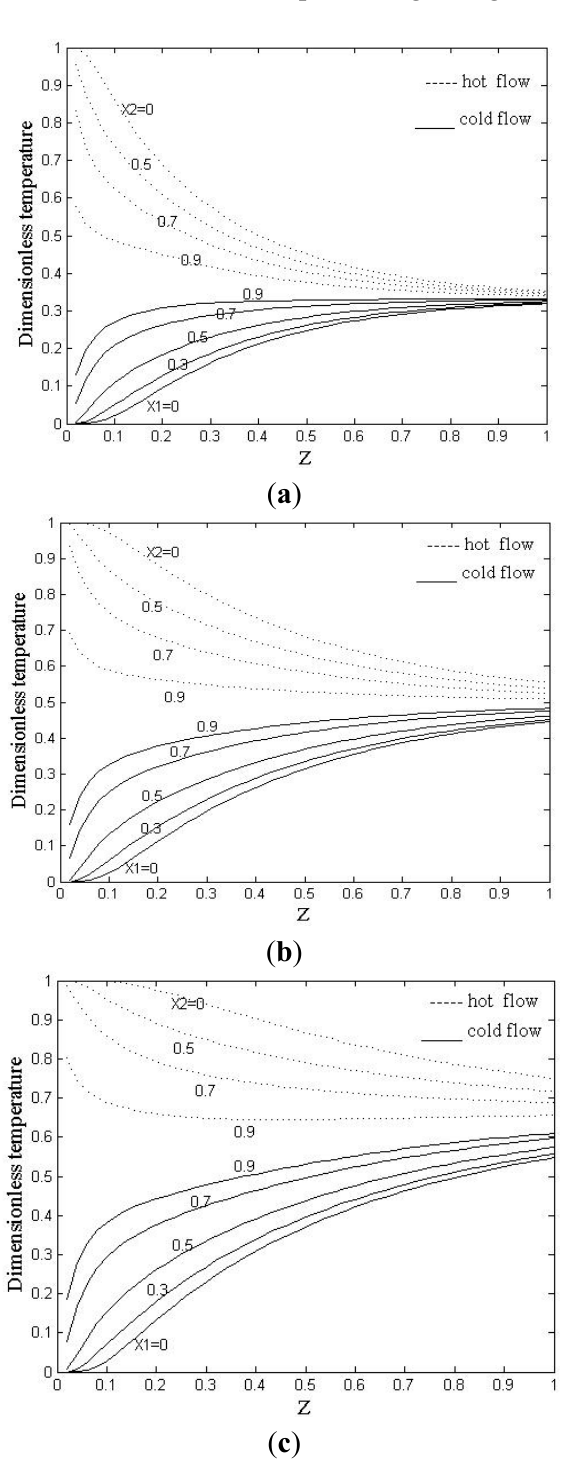
Figure 2. Temperature distribution for a parallel flow plate heat exchanger (Plug flow). ( a ) Two dimensional temperature distribution for K = 1, H = 0.5, K W = 0; ( b ) Two dimensional temperature distribution for K = 1, H = 1, K W = 0; ( c ) Two dimensional temperature distribution for K = 1, H = 2, K W =